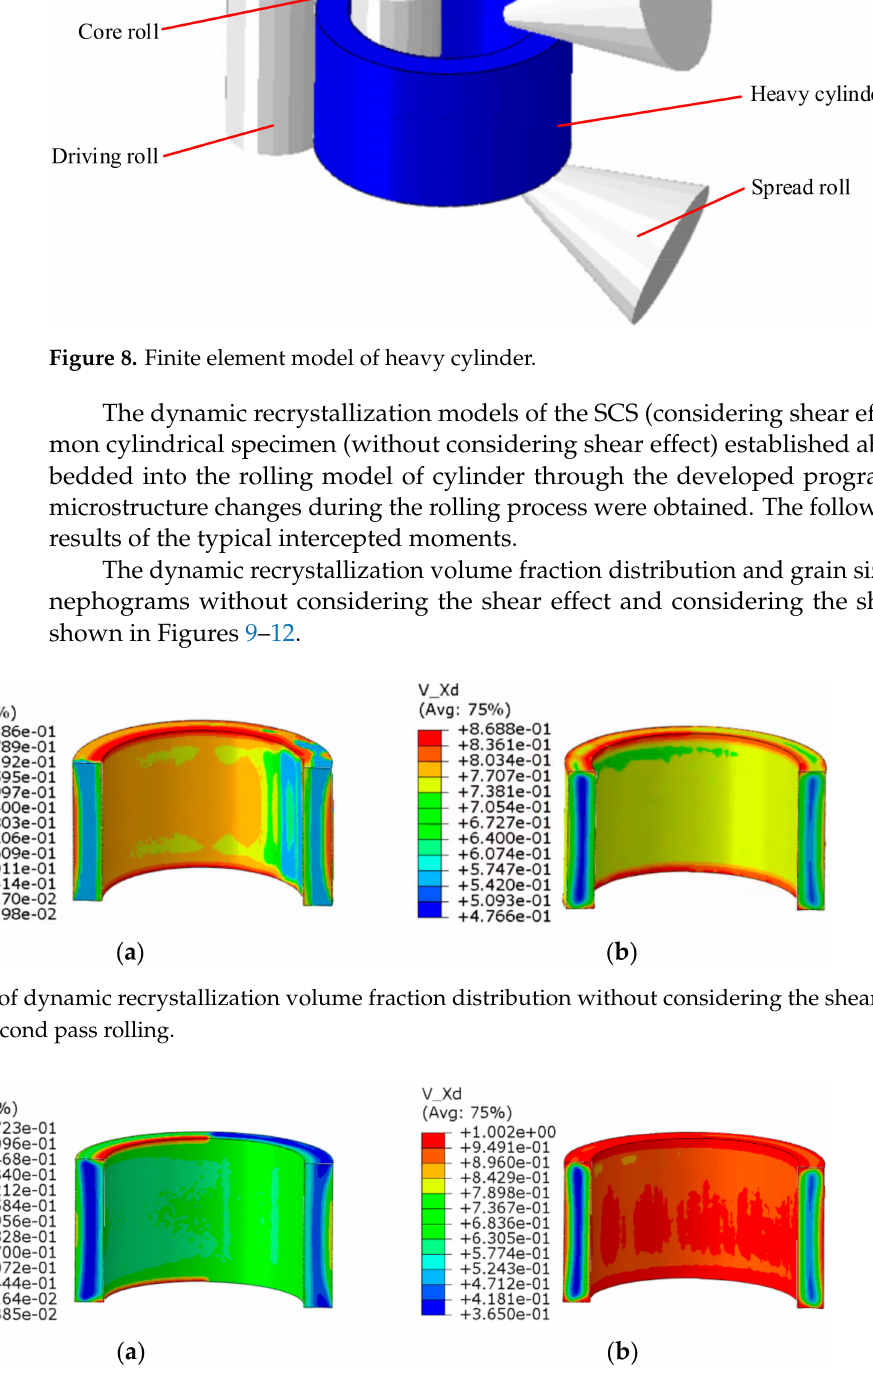
Figure 10. Nephogram of dynamic recrystallization volume fraction distribution considering the shear effect: ( a ) first pass rolling; ( b ) second pass